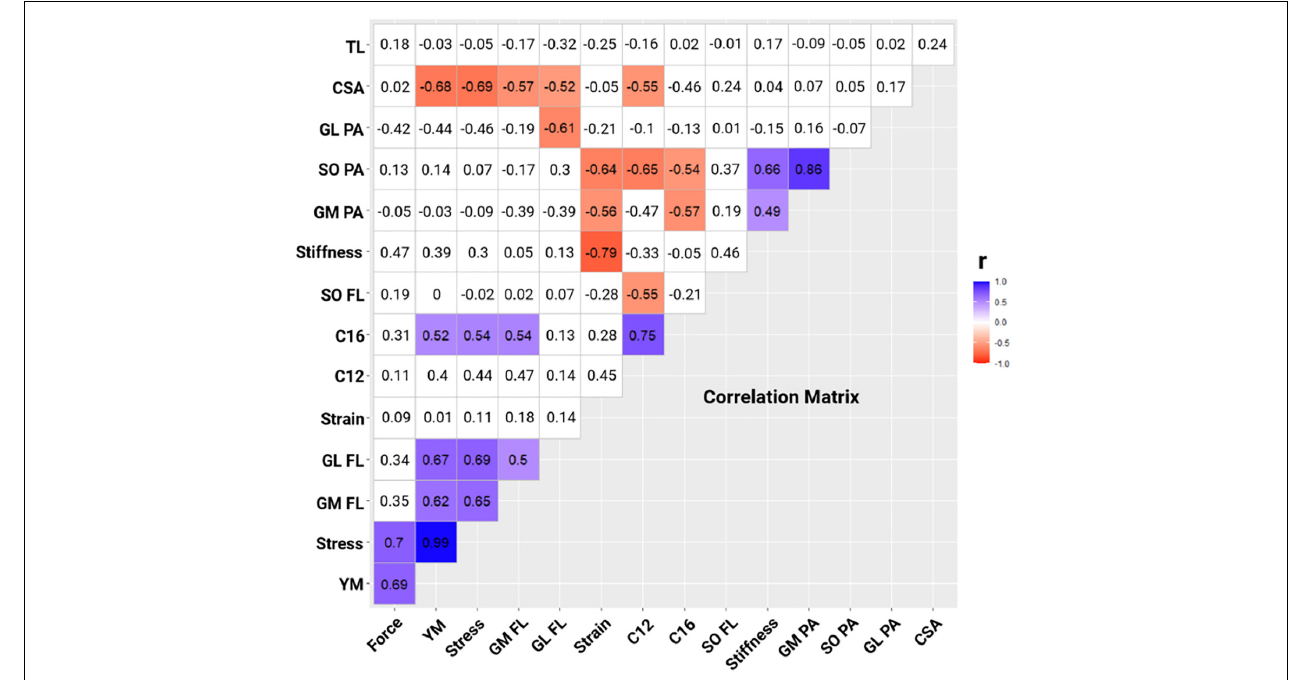
FIGURE 2 | Correlation matrix between metabolic cost- C [C12 at 12 km h − 1 ; C16 at 16 km h − 1 ] and plantar flexor muscle-tendon properties [CSA, Achilles tendon cross-section area; GL FL, gastrocnemius lateralis fascicle length; GL PA, gastrocnemius lateralis pennation angle; GM FL, gastrocnemius medialis fascicle length; GM PA, gastrocnemius medialis pennation angle; SO FL, soleus fascicle length; SO PA, soleus pennation angle; TL, tendon length; YM, Young’s modulus]. Blue cells show a significant positive correlation between the variables; red cells show a significant negative correlation between the variables ( p < 0.05); and white cells show non-significant correlations between the variables ( p >